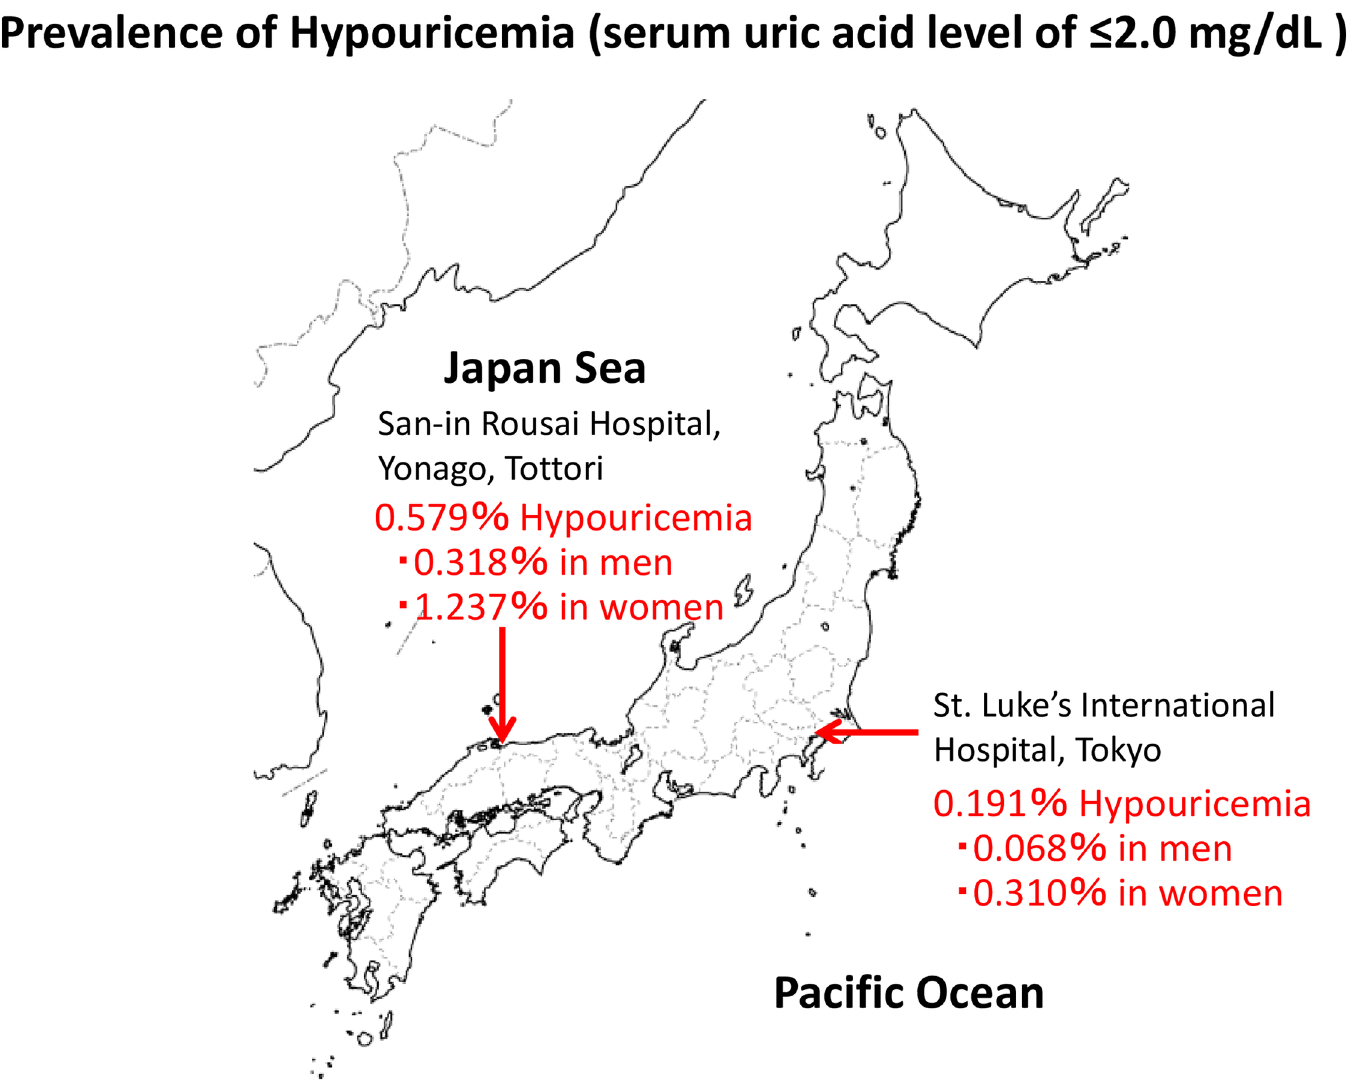
Fig 1. Prevalence of hypouricemia (serum uric acid level of (cid:20) 2.0 mg/dL). The prevalenceof hypouricemia in Yonago(Japan Sea side) is significantly higherthan that in Tokyo (Pacific side) (0.579% vs 0.191%, p < 0.001).The prevalence of hypouricemia in women was larger than that in men both in Tokyo (0.310% vs 0.068%, p < 0.001)and in Yonago(1.237% vs 0.318%, p < 0.001).